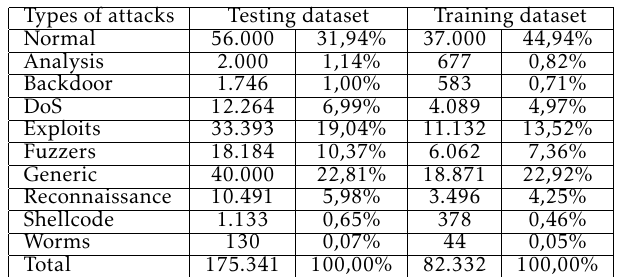
Table 2. Information about UNSW-NB15 traning and testing datasets.